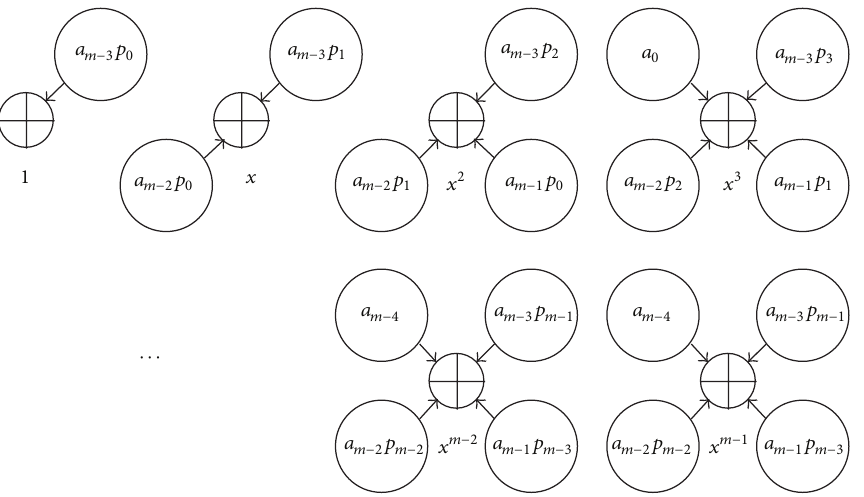
Figure 2: Proposed 𝑥 3 -multiplying circuit.